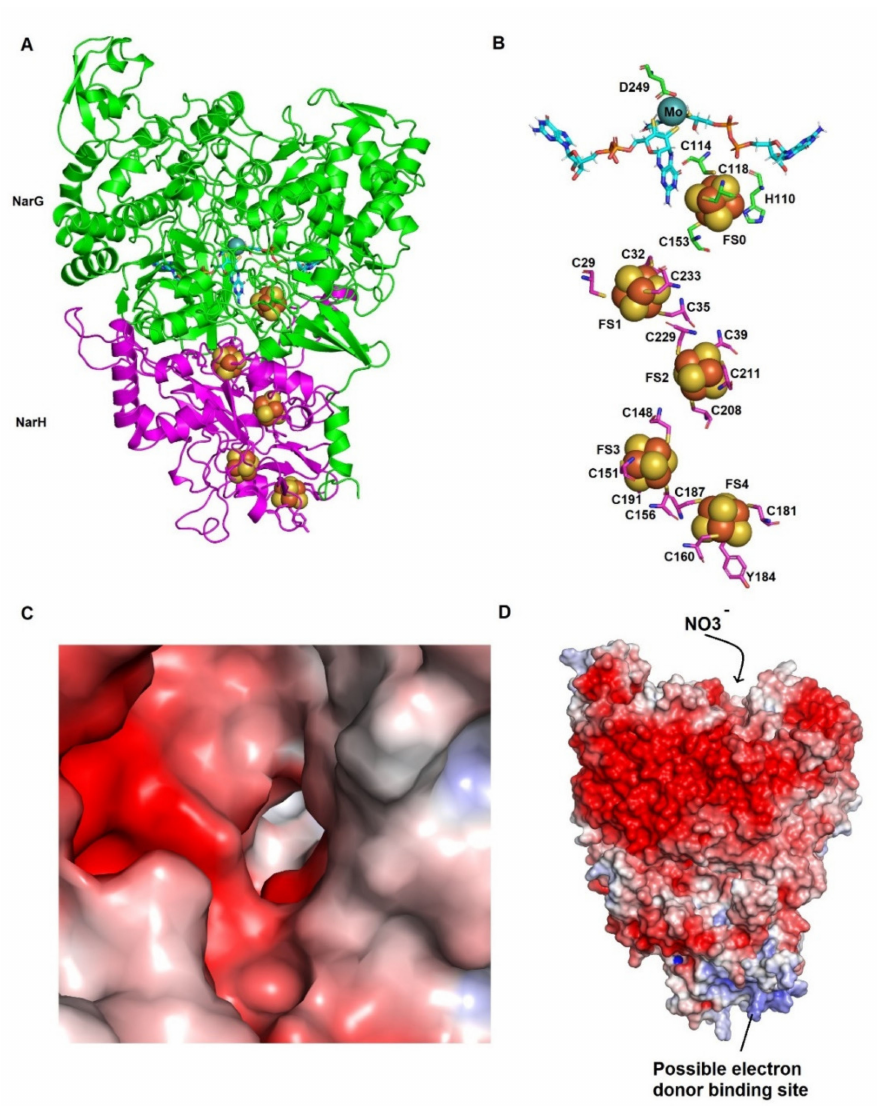
Figure 3. Homology model and electrostatic surface potential of Haloferax mediterranei NarGH. ( A ) Overall structural model of the Haloferax mediterranei NarGH dimer. NarG subunit is coloured in green cartoon and NarH subunit is coloured in magenta cartoon. Iron-sulphur clusters are shown as orange and yellow spheres, respectively. Mo- bis -MGD cofactor is represented as cyan sticks whereas molybdenum atom is coloured in turquoise. ( B ) Relative position of cofactors in Haloferax mediterranei NarGH. Amino acids involved in cofactor binding are shown as sticks. ( C ) Electrostatic surface potential of tunnel in the Haloferax mediterranei NarGH. ( D ) Electrostatic surface potential of Haloferax mediterranei NarGH dimer. The electrostatic potential is represented between +5 and − 5 kT/e .